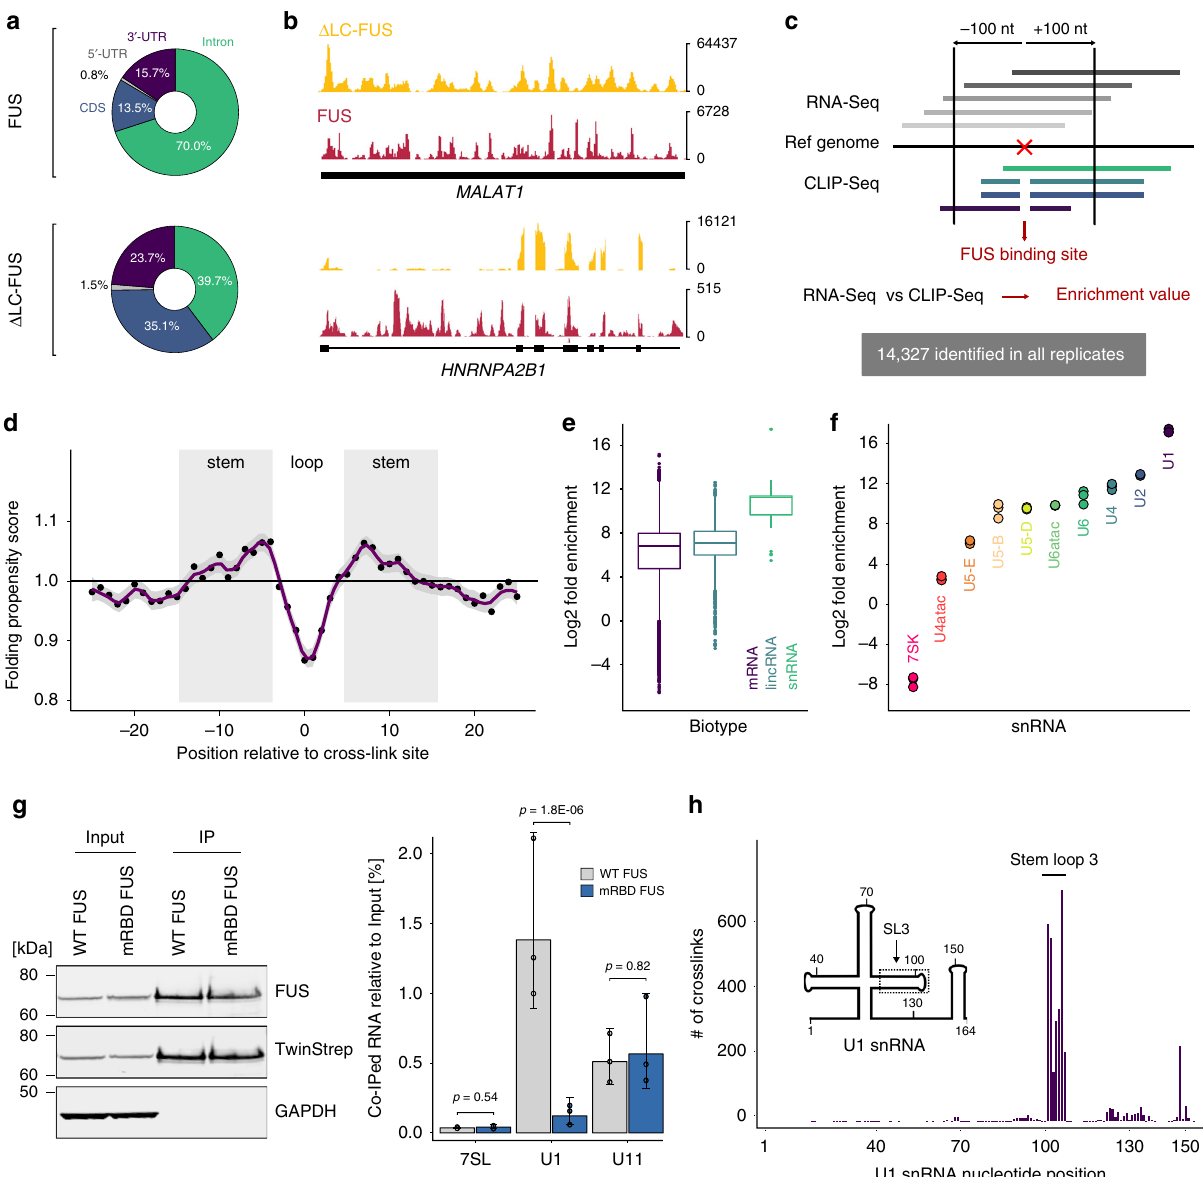
Fig. 2 CLIP-Seq reveals U1 snRNA as a major FUS target. a Read distribution of FUS and Δ LC-FUS CLIP experiments in pre-mRNAs according to the annotated transcript region. b Genome browser views showing the distribution of FUS and Δ LC-FUS CLIP reads on selected genes. c Schematic representation of the analysis approach used to infer FUS-binding sites from CLIP data. d Folding propensity of nucleotides proximal to cross-link sites identi fi ed in all biological replicates. The error band depicts the standard error of the local regression curve. n = 3. e Box plot showing the distribution of enrichment values for binding sites located in distinct transcript biotypes. The plot displays median lines, interquartile range (IQR) boxes, 1.5 × IQR whiskers and remaining data points. n = 4929 (lincRNA), 115,104 (mRNA), 125 (snRNA), examined in three biological replicates. f Dot plot showing the mean enrichment value inferred from all binding sites of individual snRNAs (corresponding to panel e) for three biological replicates. g WT and RNA- binding-de fi cient FUS was puri fi ed from HeLa cells and detected by western blotting using anti-FUS and anti-Twin-Strep antibodies. GAPDH served as a loading control. Extracts corresponding to 2 × 10 5 cell equivalents were loaded as input, IP fractions correspond to 2 × 10 6 cell equivalents. RNA levels were assessed by RT-qPCR and quanti fi ed relative to the input. Mean values and standard deviations of three biological replicates are shown. P values were computed from log-transformed values using two-sided unequal variance Welch ’ s t test. n = 3. h Bar plot displaying the number of cross-links for every nucleotide along the U1 snRNA primary